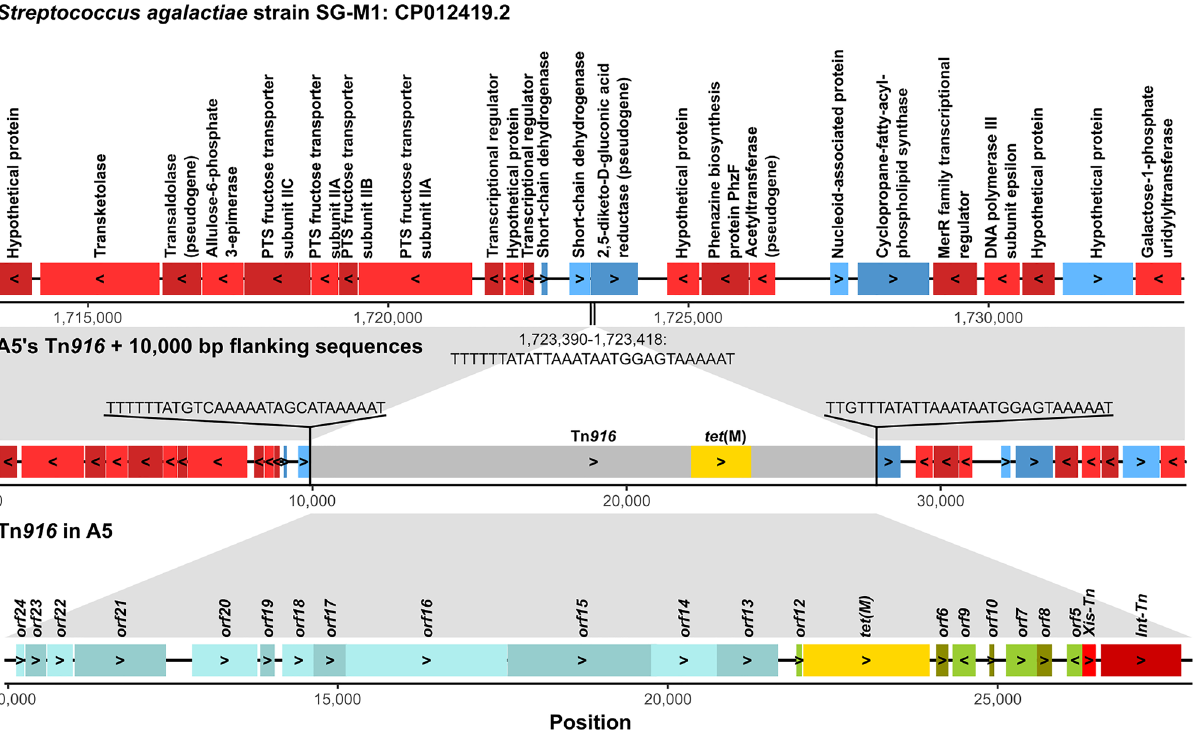
Figure 3. Tn 196 in GBS ST283. (Top) Schematic diagram illustrating an empty integration site in the reference GBS ST283 genome, strain SG-M1 (GenBank accession number: CP012419.2). Boxes represent protein coding regions, and the names of the protein products are shown on top. Genes’ directions are indicated by boxes’ colors and arrow heads drawn on the boxes (blue or “>”: forward orientation; red or “<”: reverse orientation). Sequence at the empty integration site (1,723,390 to 1,723,418) is shown. (Middle) Homologous position in A5, harboring Tn 916 . Homology between the reference genome and A5 is indicated by grey shadings. Protein coding regions in A5 were annotated by comparing its sequence to that of SG-M1 by BLASTn, showing > 99.9% nucleotide identity overall. Tn 916 is drawn in grey, and the tet (M) gene carried by the transposon is drawn in yellow. Direct repeats flanking the Tn 916 element are shown, exhibiting similarity detectable by BLASTn to the sequence at the empty integration site of SG-M1. (Bottom) Schematic diagram illustrating the genomic structure of Tn 916 in A5. Protein coding regions were annotated by comparing its sequence to the reference Tn 916 of Enterococcus faecalis DS16 (GenBank accession number: U09422.1) by BLASTn, showing > 99.9% nucleotide identity overall with 100% sequence coverage. The directions of the genes are indicated by arrow heads (“>”: forward orientation; “<”: reverse orientation) and the names of the genes are shown on top. Colors indicate to which functional modules the genes belong (blue: conjugation; green: transcriptional regulation; yellow: tetracycline resistance gene; grey: insertion and excision). The figure was generated using the ggplot2 3.3.5 54 library in R, and was arranged and labeled in Inkscape 1.0.2-2 56